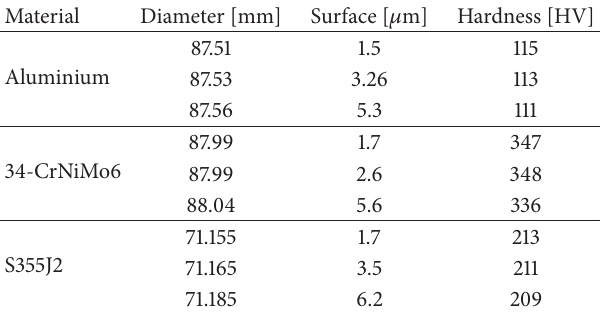
Table 1: Diameters and surface roughness values before